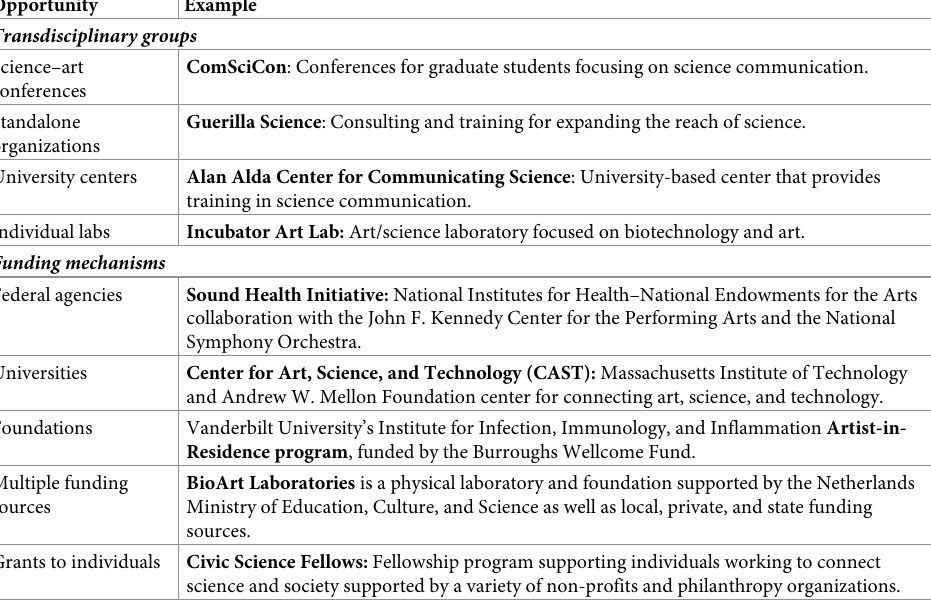
Table 1. Resources for integrating art and